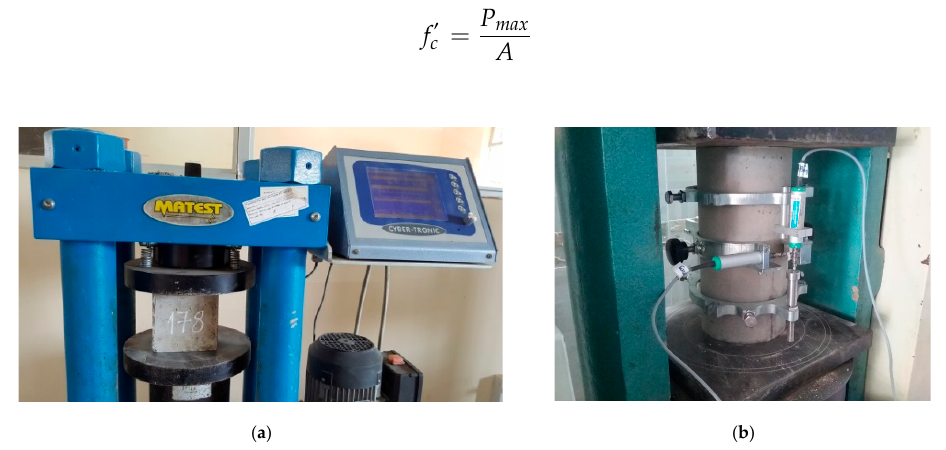
Figure 3. Photos of test setup. ( a ) Determining compressive strength. ( b ) Determining Poisson‘s ratio and modulus of elasticity.